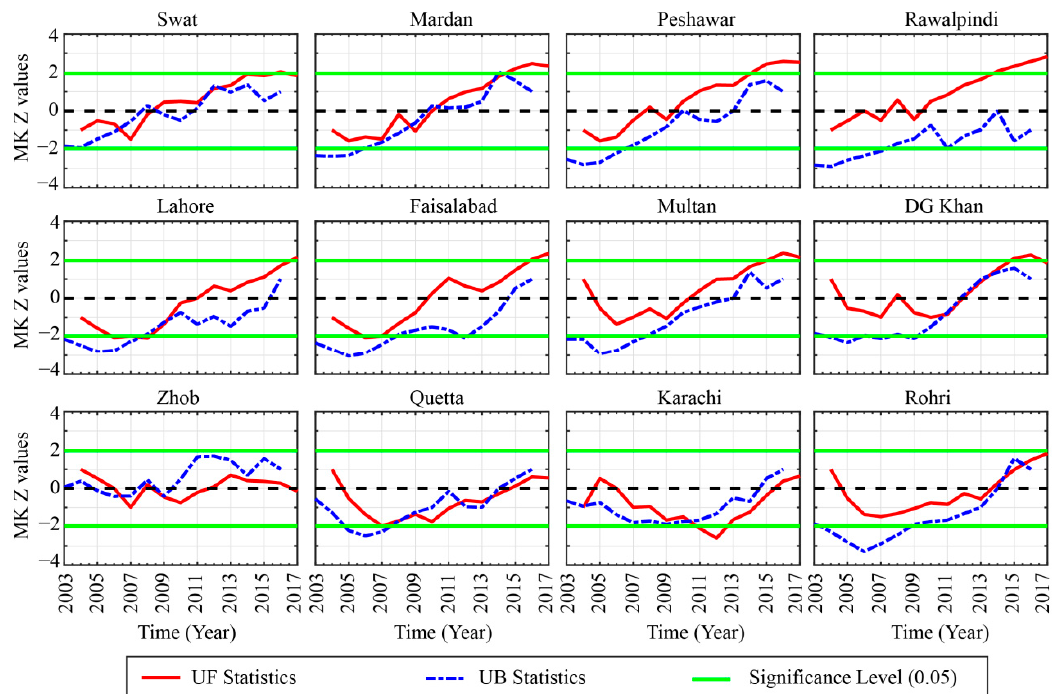
Figure 8. Abrupt changes of winter mean aerosol optical depths during 2003–2017 over the selected locations.